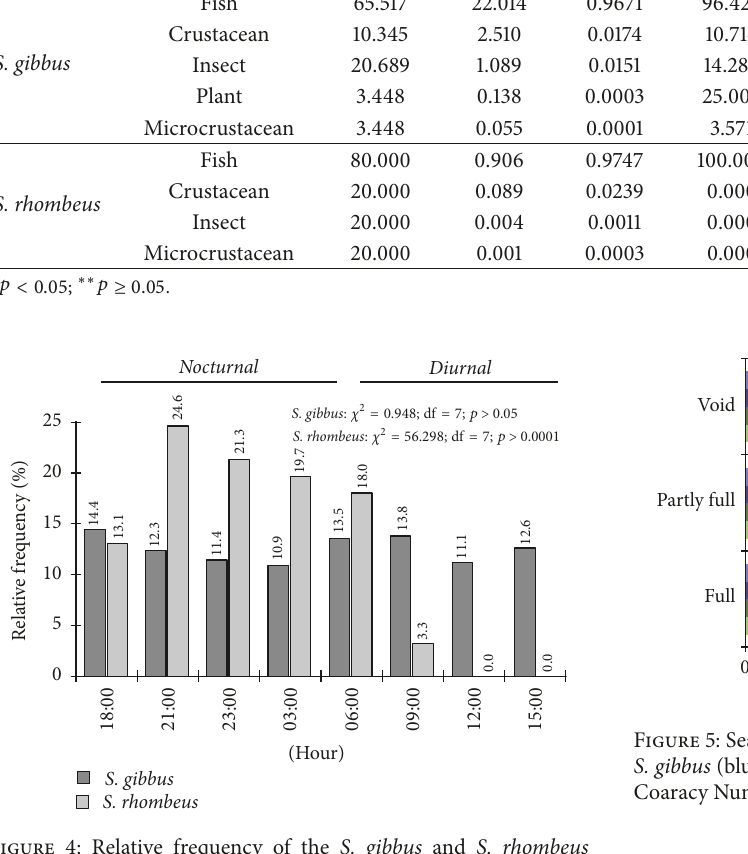
Figure 4: Relative frequency of the S. gibbus and S. rhombeus specimens captured per 3-hour interval in the Coaracy Nunes reservoir in Ferreira Gomes, Amap´a (Brazil).